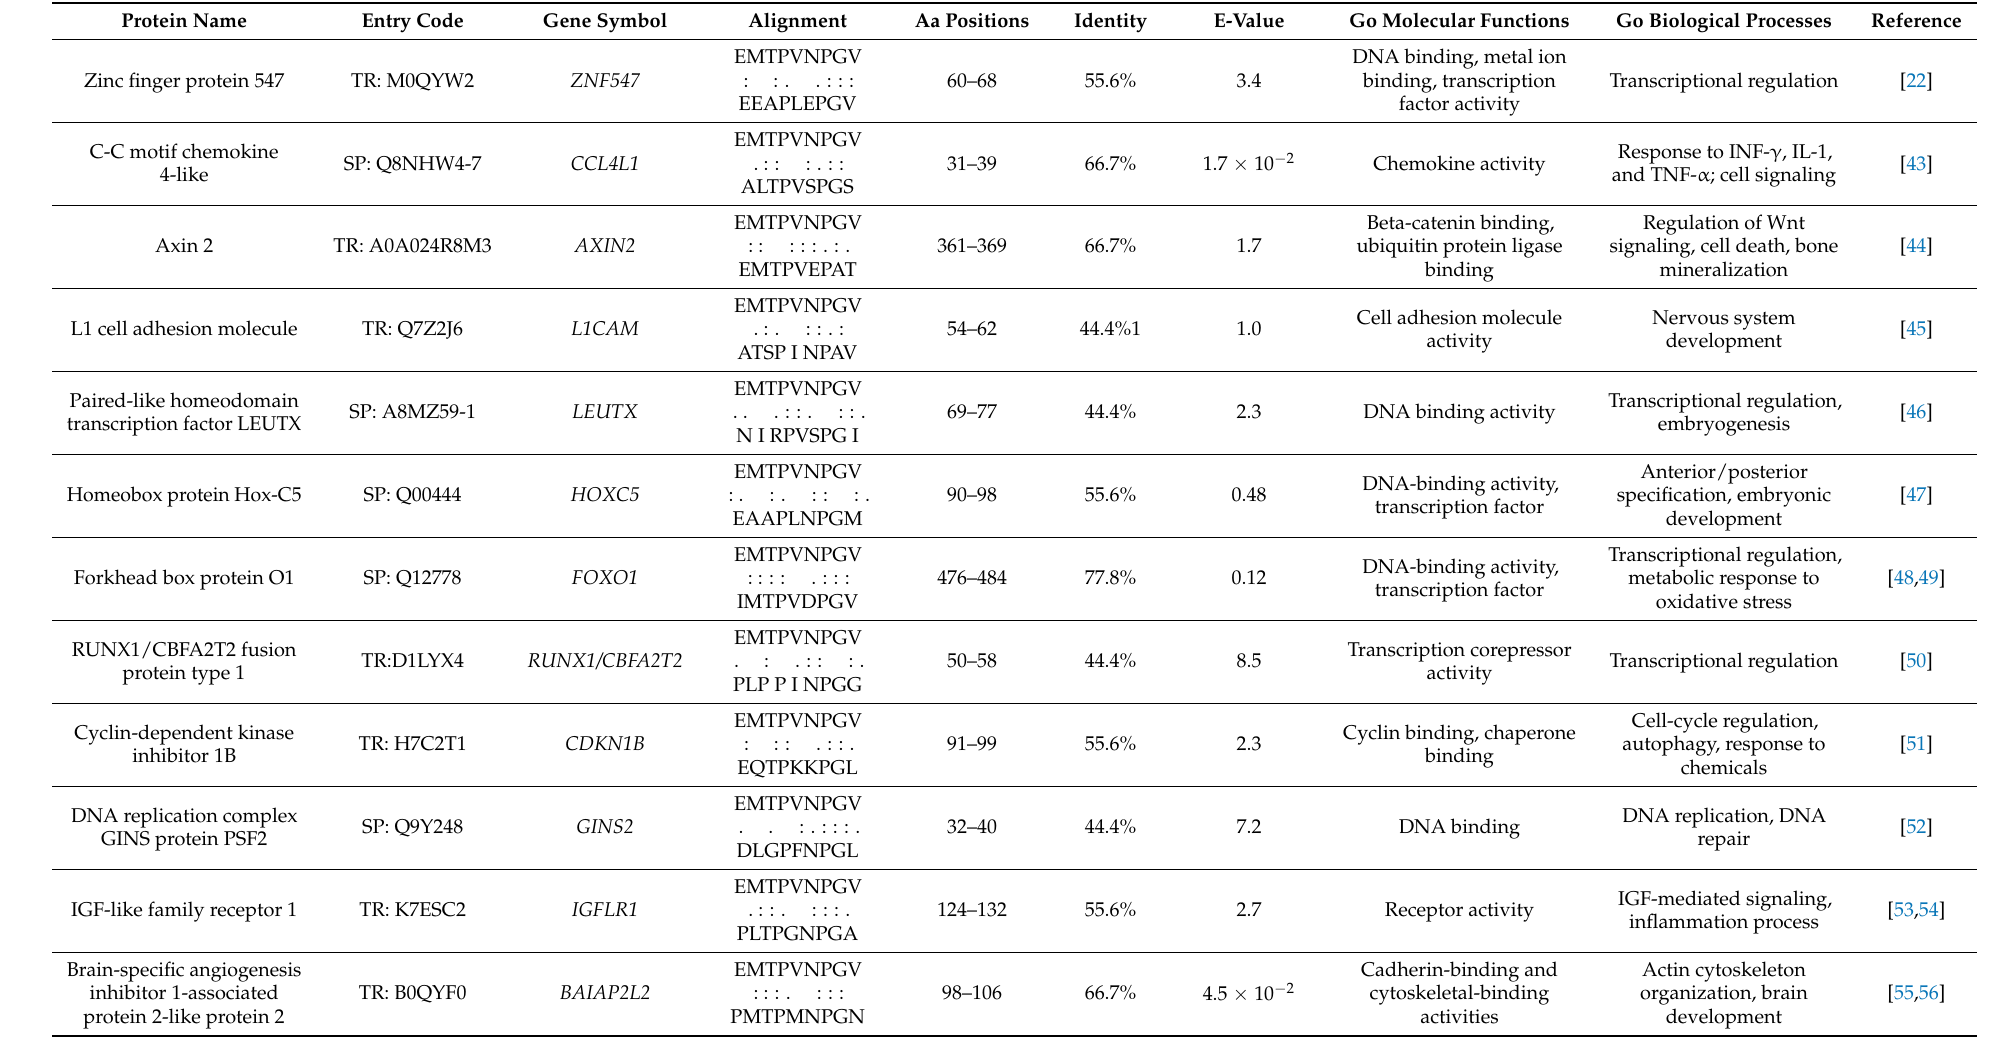
Table 2. Selected human proteins retrieved from UniprotKB knowledgebase containing GIP-9-like